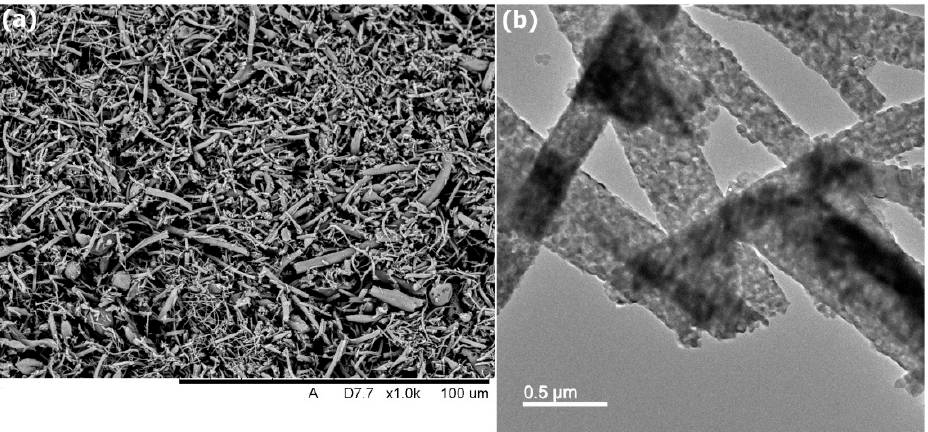
Figure 2. ( a ) SEM and ( b ) TEM images of the HANF fragments. Polymers 2019 , 11 , x FOR PEER REVIEW